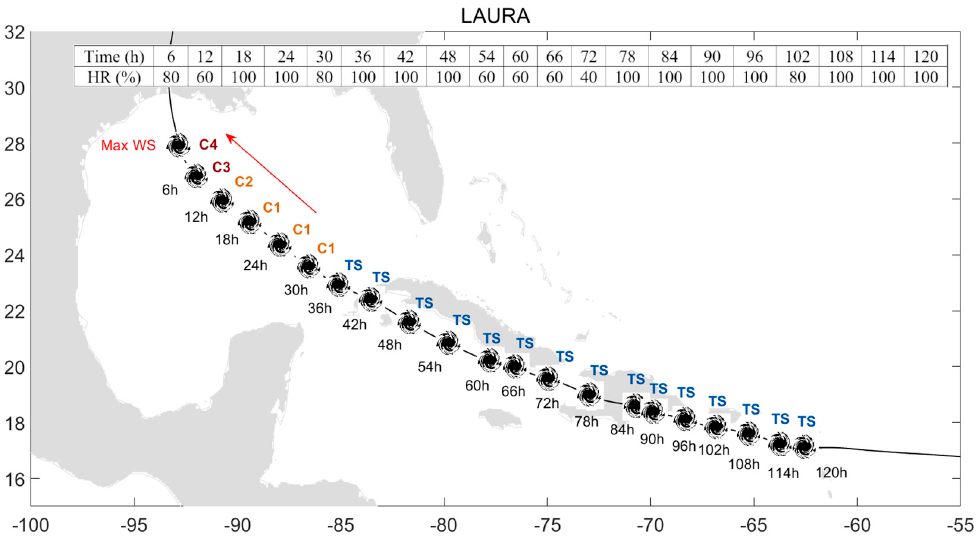
Figure 4. Analysis of the hit ratio (HR) for the different prediction models for hurricane Iota (Atlantic Ocean, 13–18 November 2018). The image shows the track of the TC under consideration for each lead time since the TS was formed (13 November 2020, at 21:00 UTC) until it reached its maximum intensity peak, or wind speed (Max WS) (16 November 2020, at 12:00 UTC). The arrow indicates the rapid increase in scale category as the TC progressed. The table shows the hit ratio (the number of times that a correct prediction was made out of the total number of predictions) of our RF classifier for each lead time (as in Tables 1–3). TS and C1-5 stand for tropical storm and category 1–5 hurricanes, respectively.